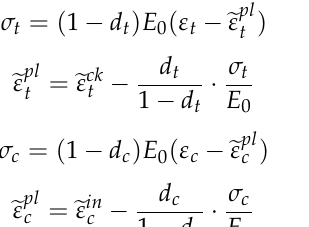
are the plastic compressive and t and (cid:101) ε ck are the c t